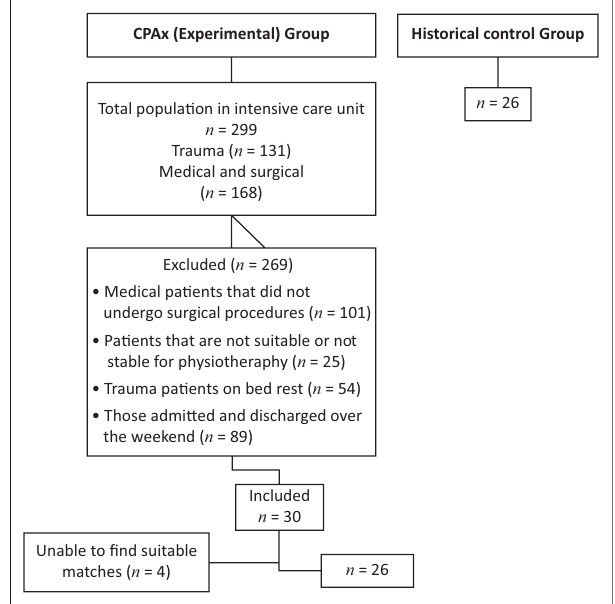
FIGURE 1: Summary of participant recruitment for the